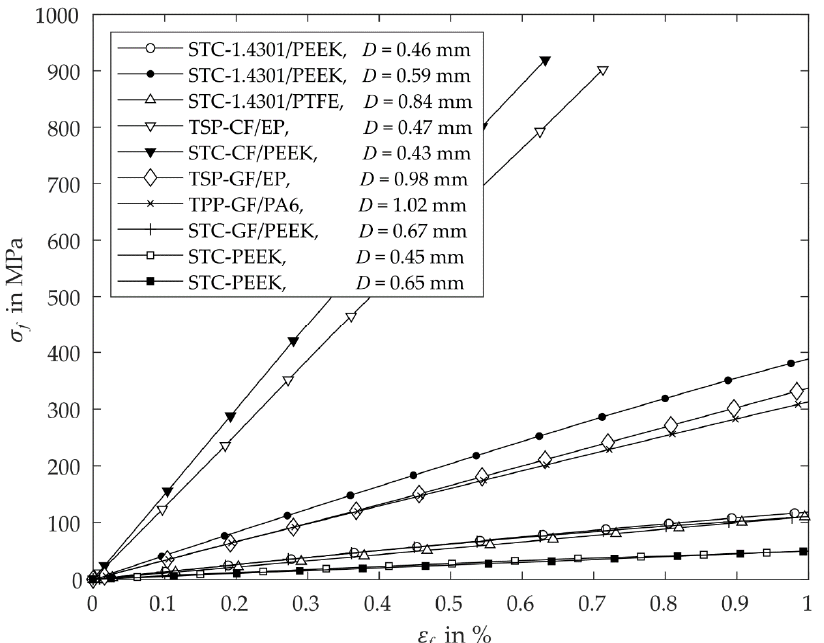
Figure 11. Averaged curve of bending stress of the different investigated wire and fibre reinforced polymer. Abbreviation: carbon fibre (CF), epoxy resin (EP), glass fibre (GF), shrink tube consolidation (STC), thermoplastic pultrusion (TPP), thermoset pultrusion (TSP), polyamide (PA), polyether ether ketone (PEEK), polytetrafluoroethylene (PTFE).